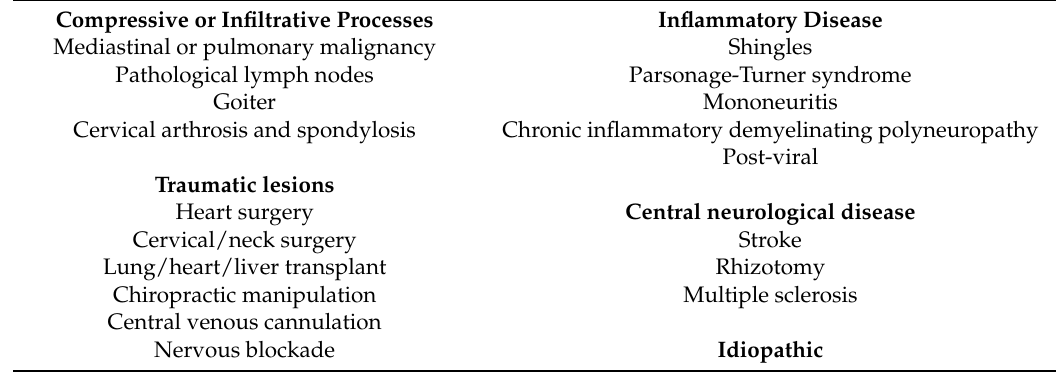
Table 2. Principal causes of unilateral diaphragm weakness (partial or complete loss of contractility). Compressive or Infiltrative